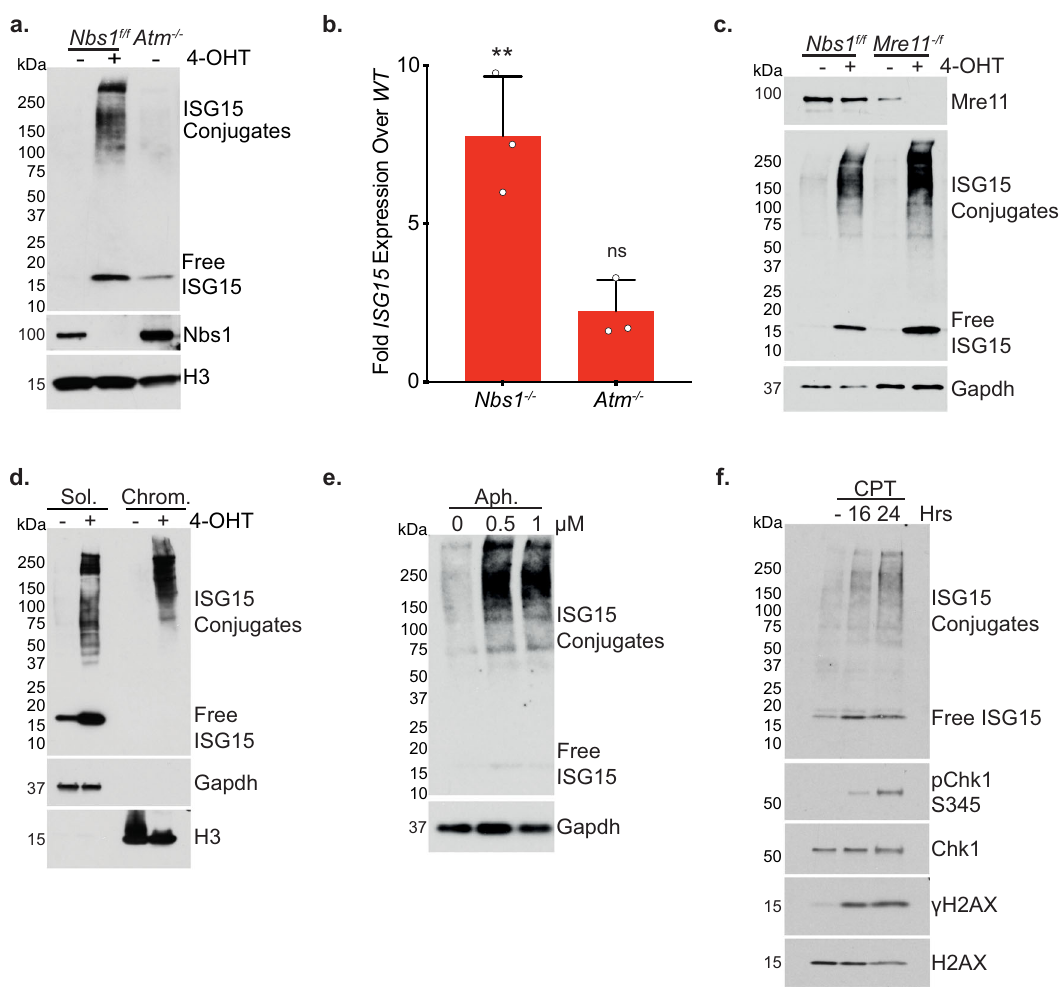
Fig.2|LossofMre11ComplexFunctionInducesISG15andISGylation.a Western blot of wholecellextractstakenthree dayspost4-OHTaddition orfromuntreated control. b ISG15 expression measured by qPCR. Nbs1 − / − is three days post 4-OHT addition. Mean of three independent experiments shown with SD. Two-tailed unpaired t -test, ns= not signi fi cant, **= p 0.0034. c Western blot of whole cell extracts from cells with or without induction of Nbs1 or Mre11 deletion (3- and